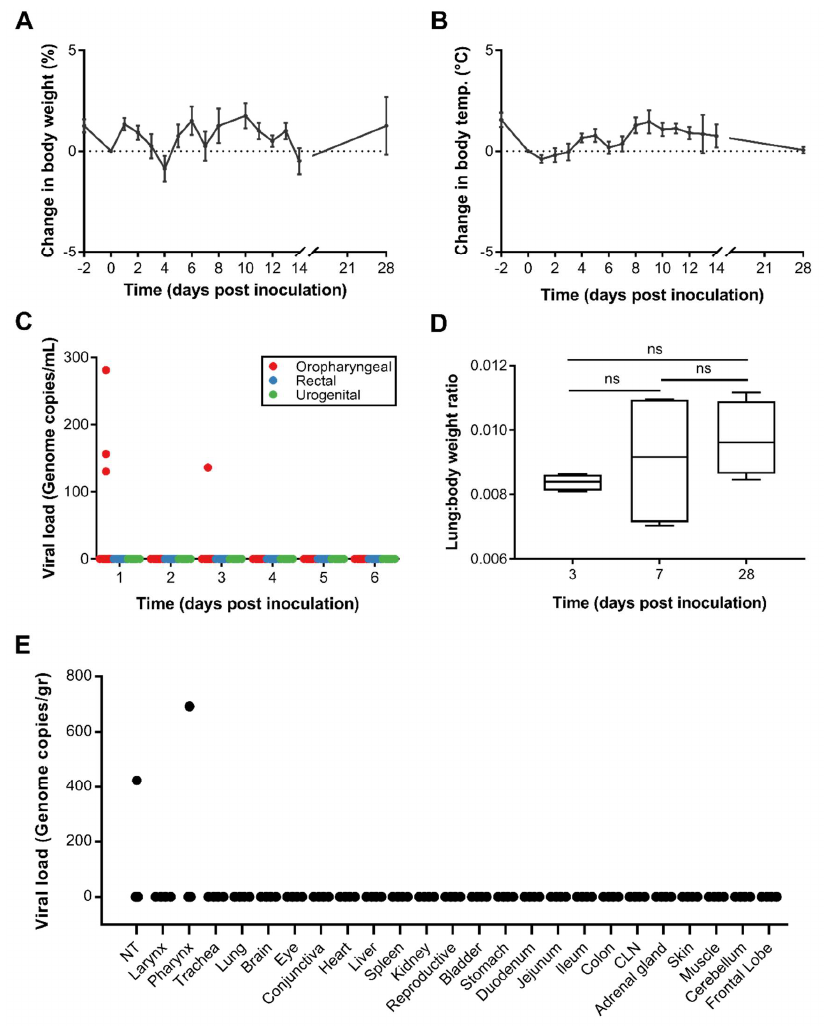
Figure 3. Disease symptoms, shedding and tissue tropism after inoculation with WIV1-CoV. ( A ) Relative weight change and ( B ) body temperature change in Egyptian fruit bats following inoculation with WIV1-CoV. ( C ) Viral RNA in oropharyngeal, rectal, and urogenital swabs obtained daily. ( D ) Lung:body weight ratio of Egyptian fruit bats at 3, 7, and 28 dpi. ( E ) Viral RNA load in tissues obtained 3 dpi (N=4 bats).